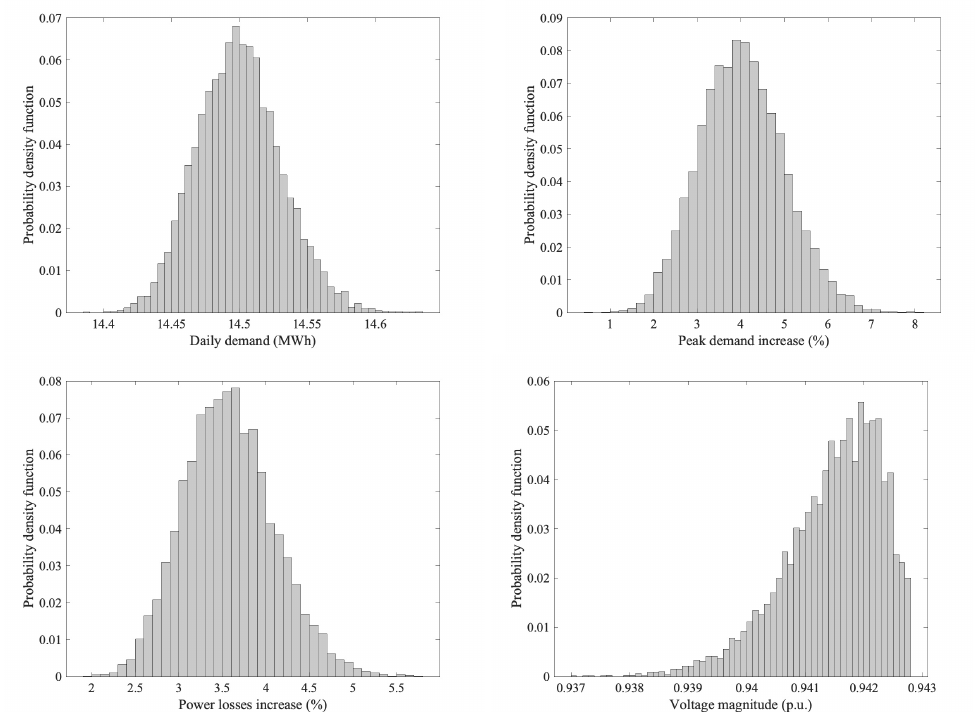
Figure 15. The histograms of the change in daily demand ( top-left ), peak demand ( top-right ) power losses ( bottom-left ), and minimum voltage ( bottom-right ) of all simulated scenario with 20% EVs deployment rates.